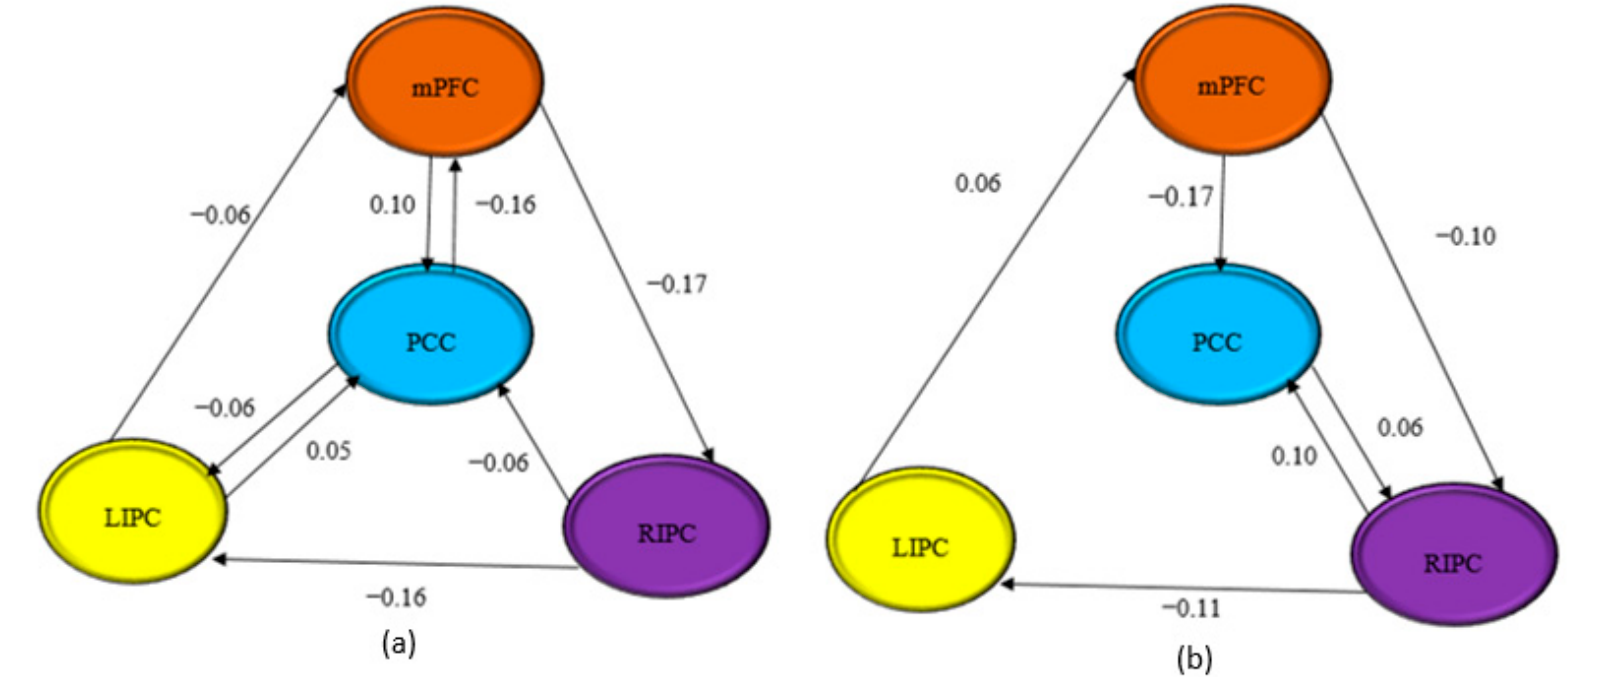
Figure 7. Model 7, the optimum model for connectivity analysis for both scanning times ( a ) 10 and ( b ) 15 min.